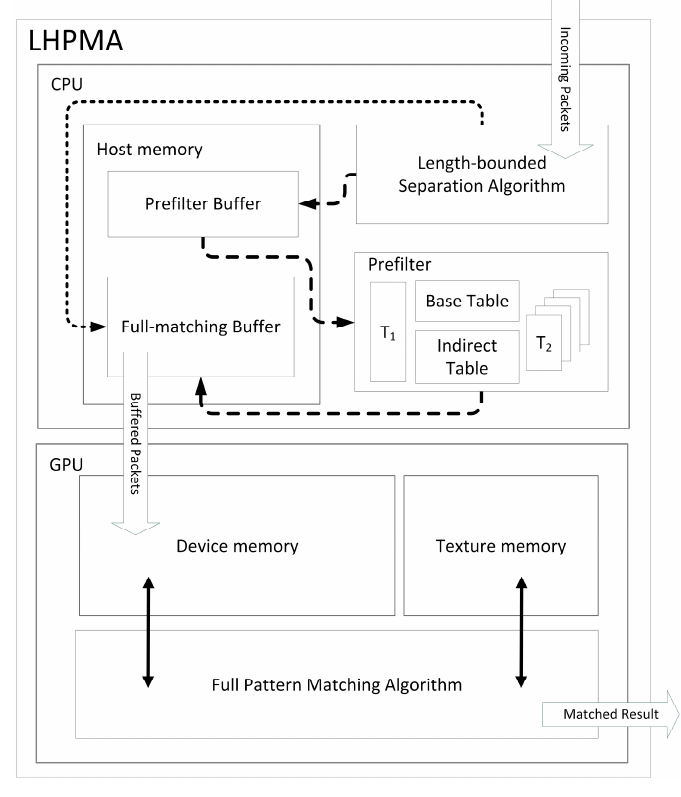
Figure 2. LHPMA architecture.